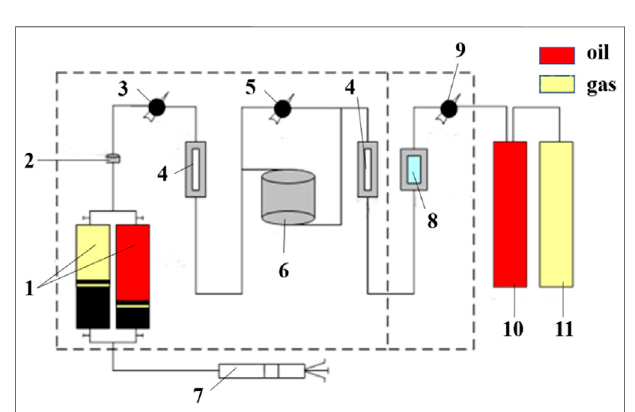
FIGURE 3 | Flow chart of slim tube text. 1: Intermediate container; 2: Filter; 3: Injection pressure gauge; 4: Observation window; 5: Differential pressure gauge; 6: Slim tube; 7: Injection pump; 8: Pressure regulator; 9: B Back pressure gauge; 10: Liquid meter; 10: Gas meter.